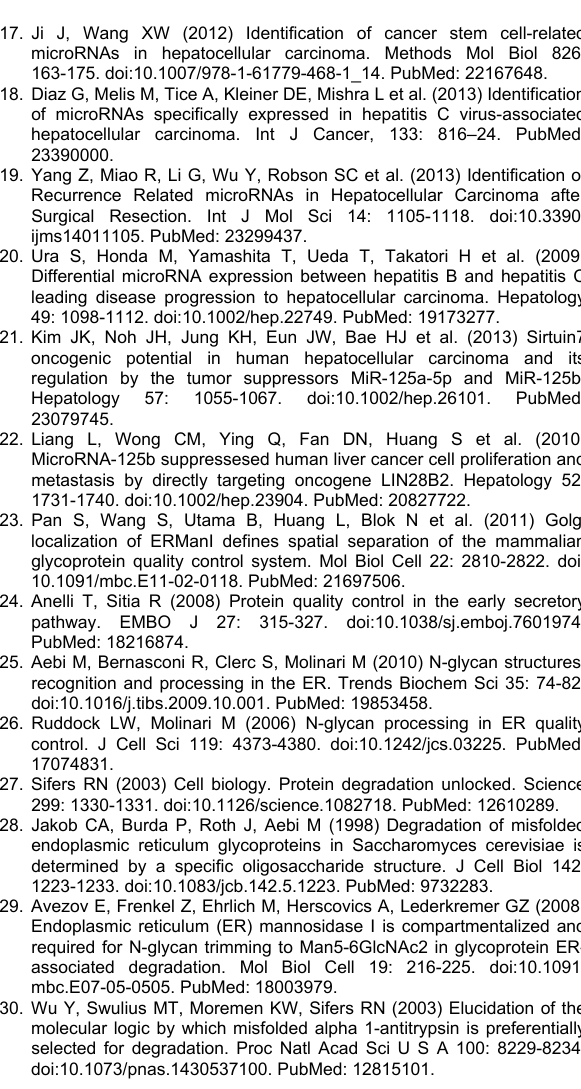
Figure S2. Downregulation of ERManI inhibits proliferation of HepG2 cells. Growth curve of HepG2 cells 72hr after transfection with control siRNA or ERManI siRNA #1. Error bars represent standard deviations from three replicates.